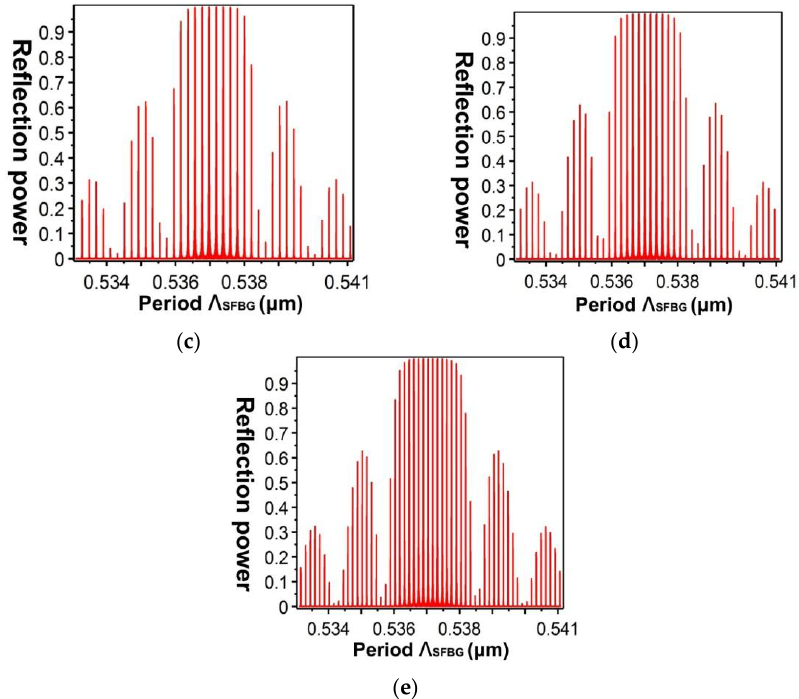
Figure 15. Relationship between the SFBG period and reflection power: ( a ) duty cycle = 50%; ( b ) duty cycle = 33.33%; ( c ) duty cycle = 14.28%; ( d ) duty cycle = 12.5%; ( e ) duty cycle = 10%.